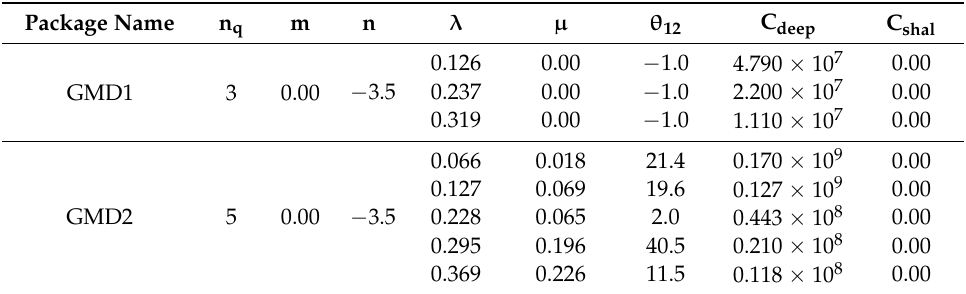
Table 1. The tuned parameters used in this study when Generalized Multiple DIA (GMD) packages are